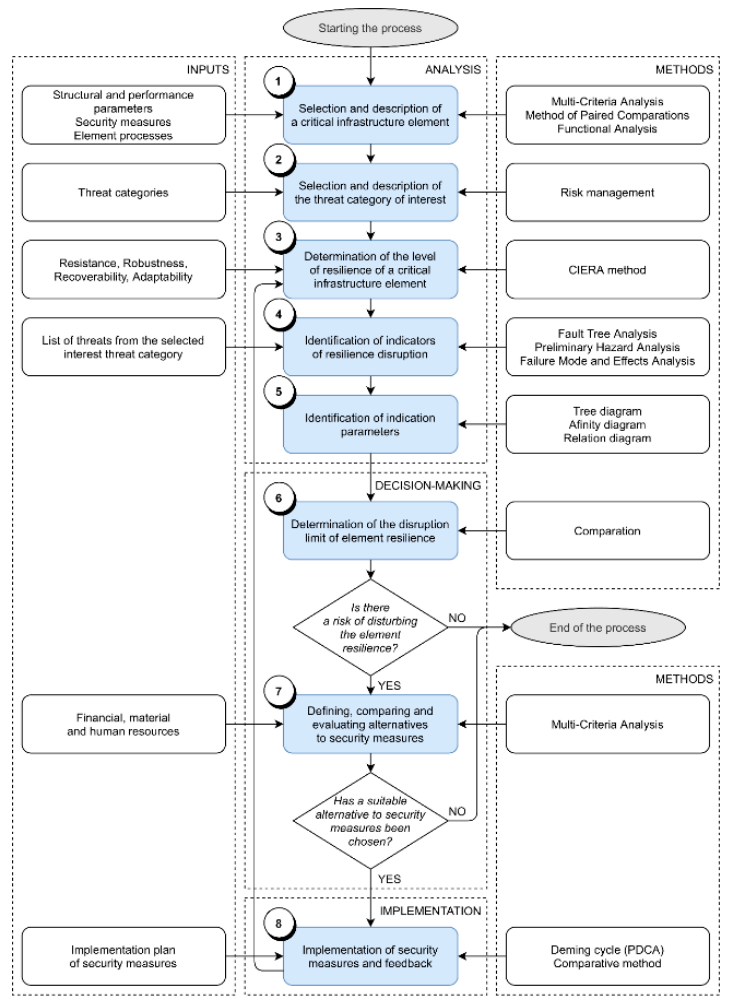
Figure 3. The process of indicating the disruption of the resilience of critical infrastructure elements.